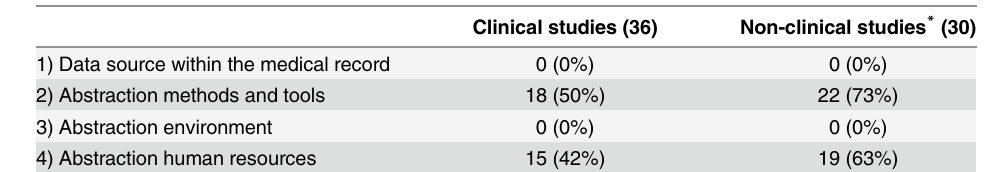
Table 6. Frequency of reporting MRA